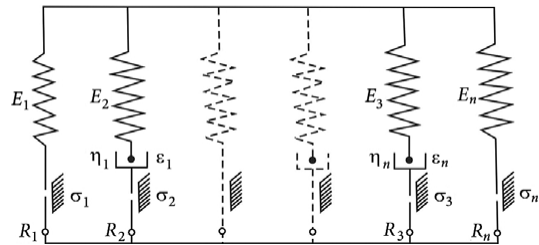
Fig. 1. Phenomenological model of asphalt